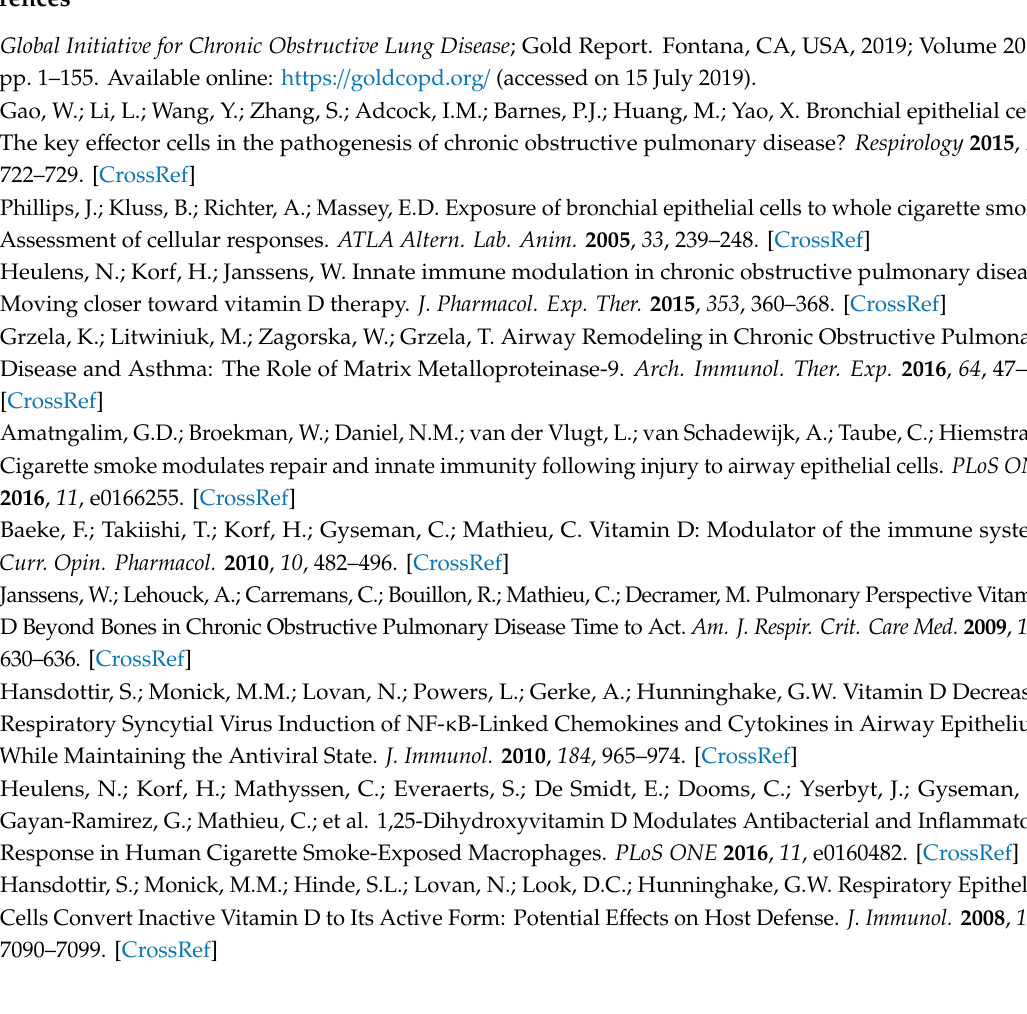
Figure S1: Examples of di ff erentiated PBEC cultures from an unused donor lung ( A ) and a COPD explant lung ( B ) Cilia are indicated by the blue arrow (40 × magnification).; Figure S2: Cytotoxicity test of CSE and vitamin D exposure on 16HBE; Figure S3: E ff ect of CSE and TX527 exposure on 16HBE; Figure S4: E ff ect of CSE and 1.25(OH) on E-cadherin and Fibronectin protein levels in 16HBE cells; Figure S5: E ff ect of CSE and 1.25(OH)2D / TX527 exposure on VDR, CYP27B1 and iNOS expression in PBEC of unused donor lungs (upper panels) and COPD explant lungs (lower